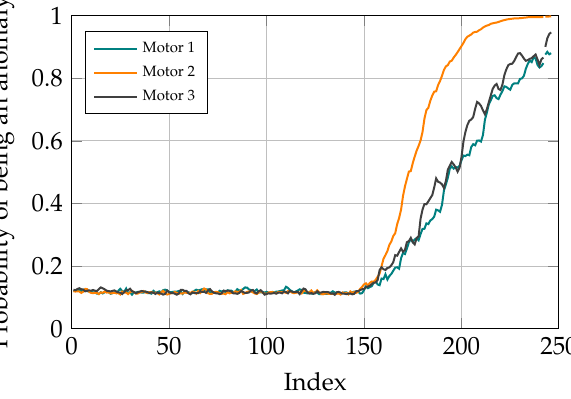
Figure 17. Simulation results with distortion added to motors 1, 2 and